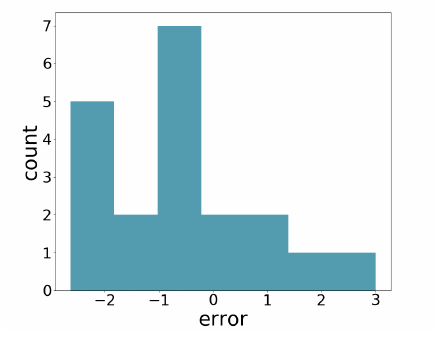
Figure 14. Error